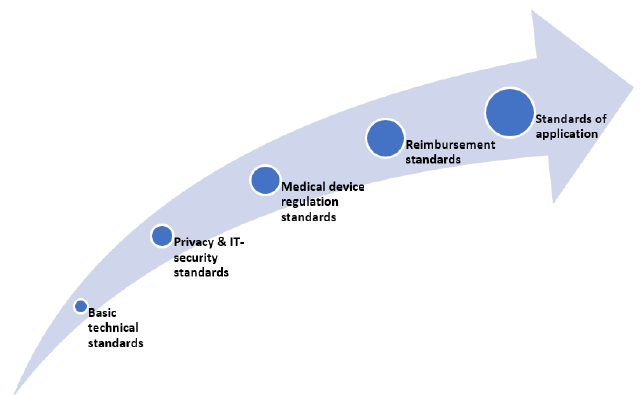
Figure 1. Regulatory and legal aspects of market access of smart